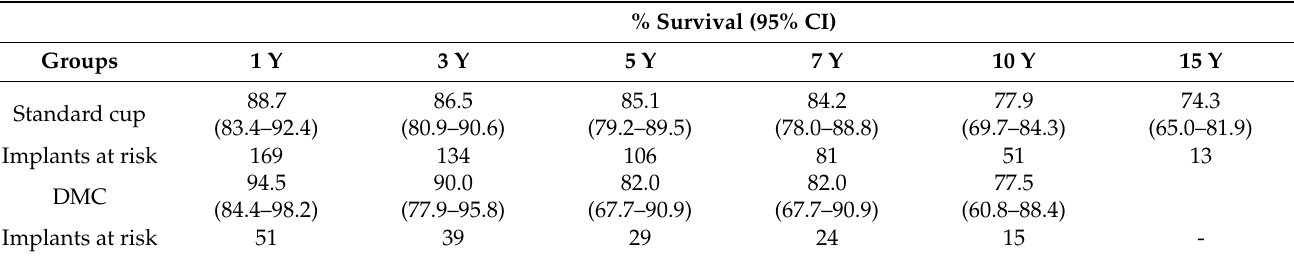
Table 5. Summary of re-failure causes.